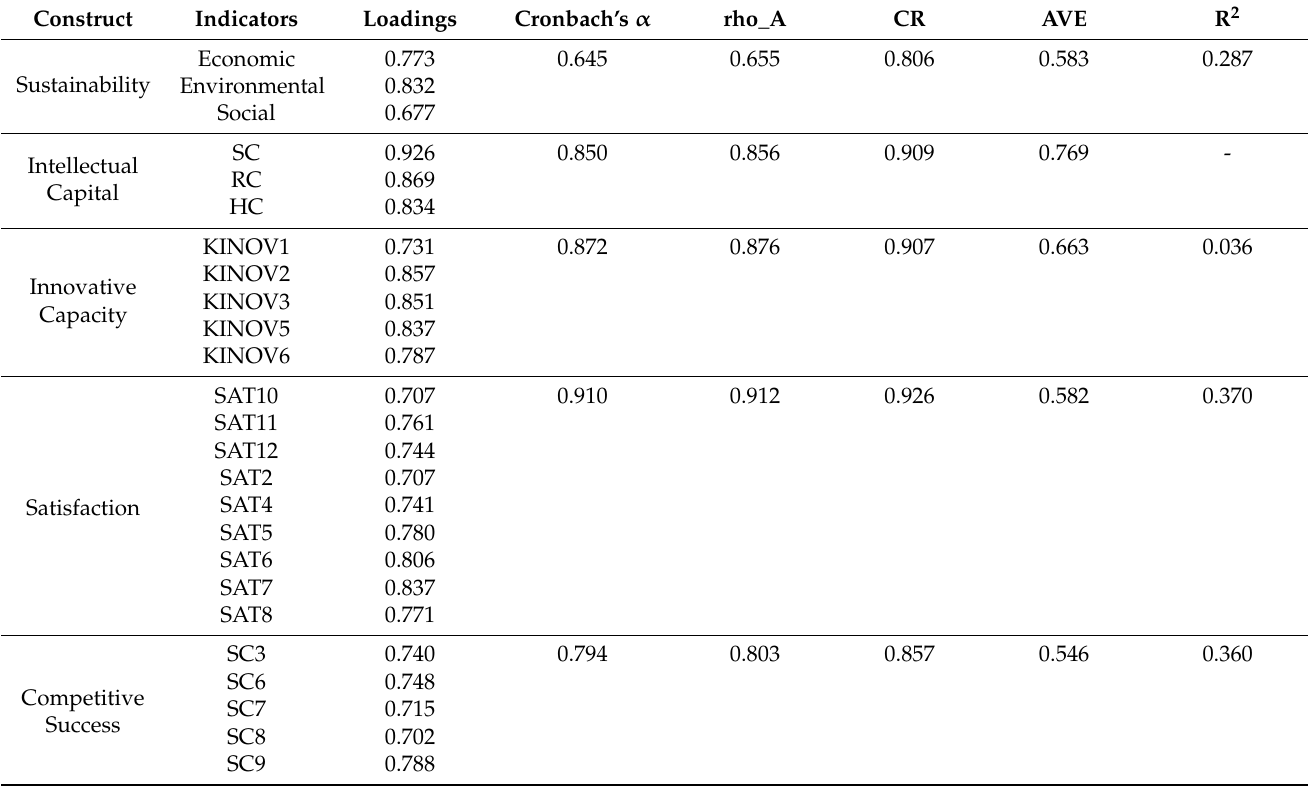
Table 2. Adjustment quality